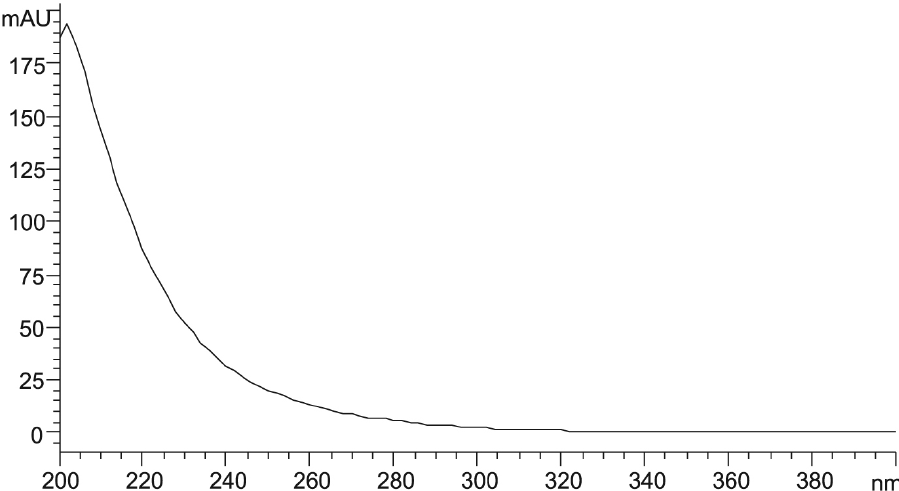
FIGURE 2 – Ultraviolet spectrum obtained at DAD, using an artemether solution at 4 mg/mL in mobile phase, injection volume of 20